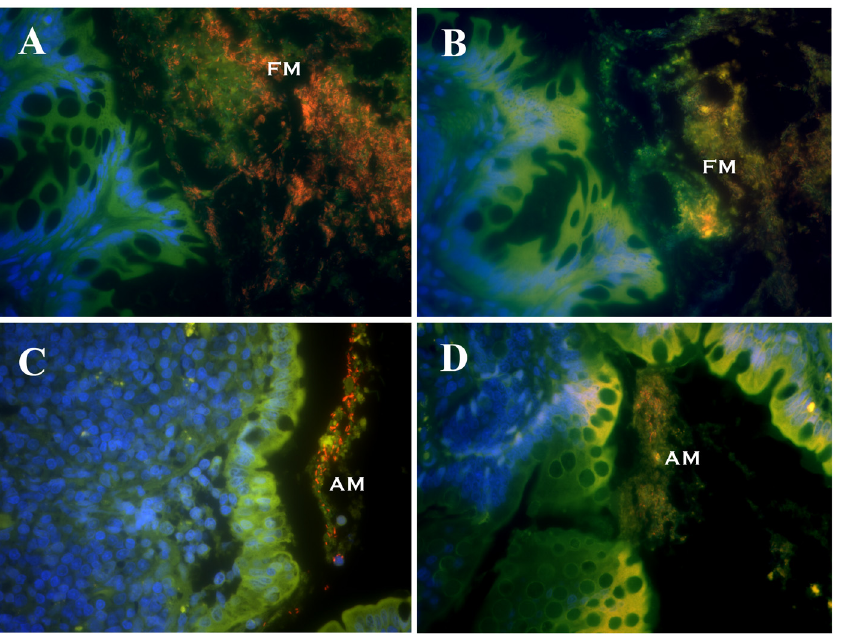
Fig 1. FISH of canine endoscopic biopsies. Triple color FISH identifies bacterial organisms within different mucosal compartments of endoscopic ileal and colonic biopsies obtained from healthy dogs. Panel A = colon biopsy hybridized with Cy3-Ebac1790; Panel B = colon biopsy hybridized with Cy3-Bac303; Panel C = ileum hybridized with Cy3-Ebac1790; and Panel D = ileum hybridized with Cy3-Ec ( E . coli ). All other bacteria that hybridize exclusively with the universal probe (Eub338-FITC) appear green. DAPI-stained colonic mucosa with goblet cells appears blue. FM = free mucus; AM = adherent mucus.